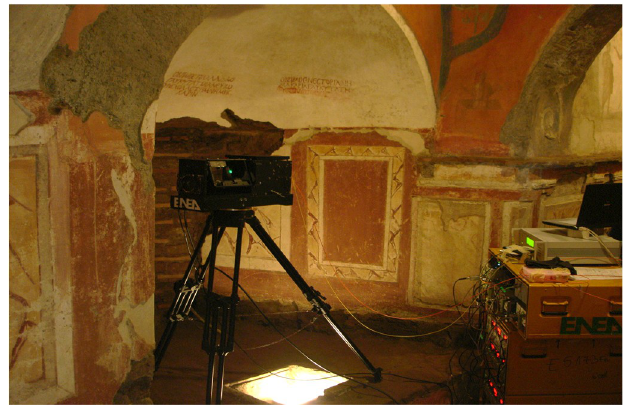
Figure 5. The Greek Chapel inside the Priscilla Catacombs in Rome (Italy): photographic images of the RGB-ITR system during the scan (Photo: S. Ceccarelli).